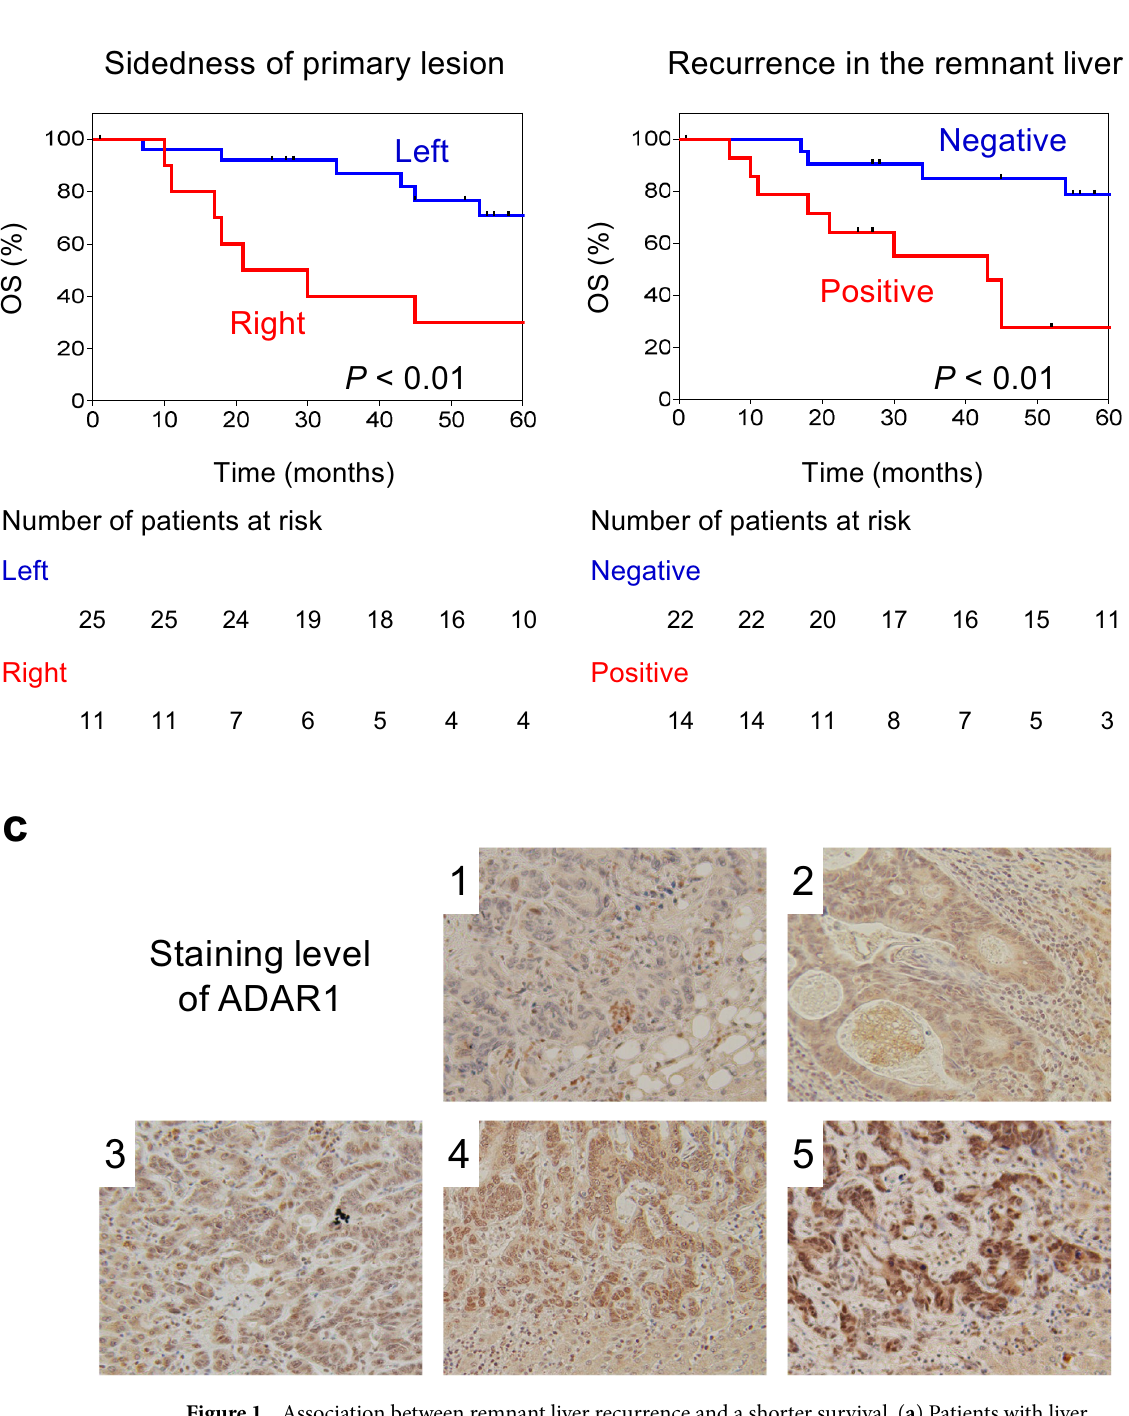
Figure 1. Association between remnant liver recurrence and a shorter survival. ( a ) Patients with liver metastasis from right-sided colorectal cancer had worse overall survival (p < 0.01). ( b ) Patients with remnant liver recurrence after liver metastatic tumor resection had a significantly shorter survival (p < 0.01). ( c ) The level of ADAR1 staining was evaluated using staining scores ranging from 1 to